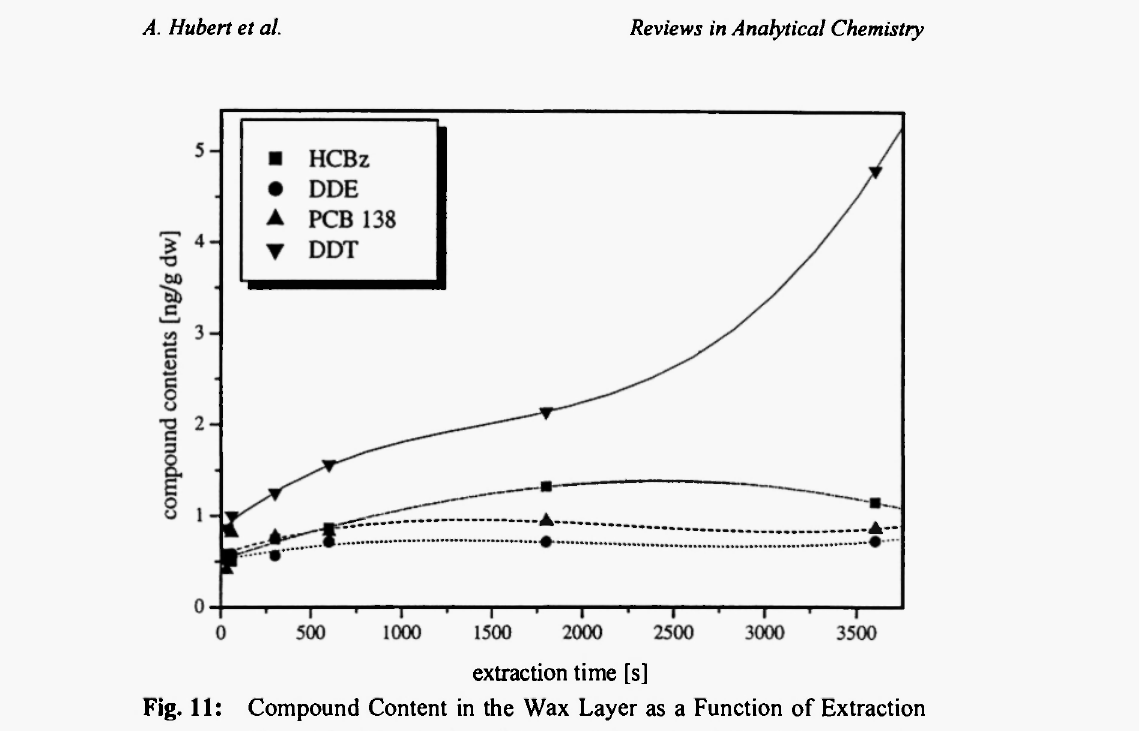
Fig. 11 : Compound Content in the Wax Layer as a Function of Extraction Time. The Four Series of Data and Associated Fitted Curves Refer to the Compounds HCB, DDT, DDE, and PCB 128, Respectively